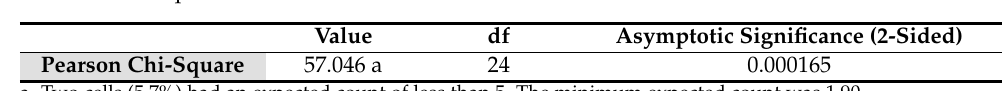
Table 23. Chi-square tests.